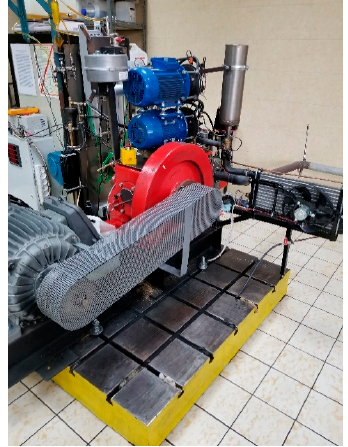
Figure 4. View on the engine at the test bed.